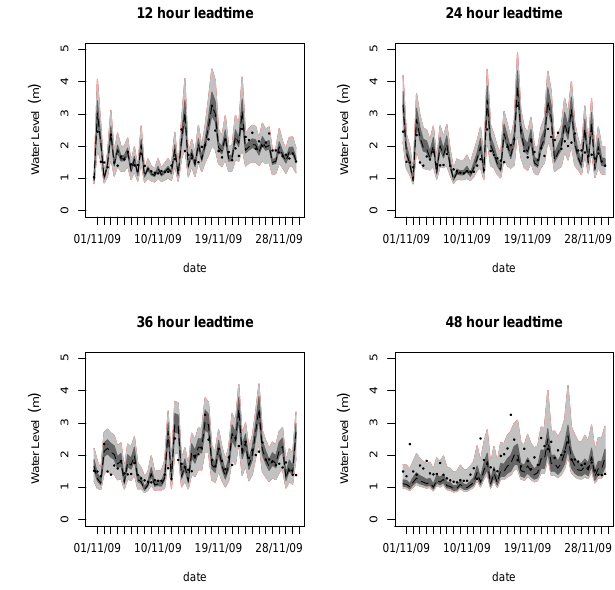
Fig. 5. Validation of Quantile Regression method for water level forecasts at Todmorden for the January 2009 events for 2, 6, 12 and 24h leadtimes. The dark grey area represents the 50% confidence interval and the light grey area represents the 90% confidence inter- val, the black dashed line the 50% estimate, and the black dots the observations.